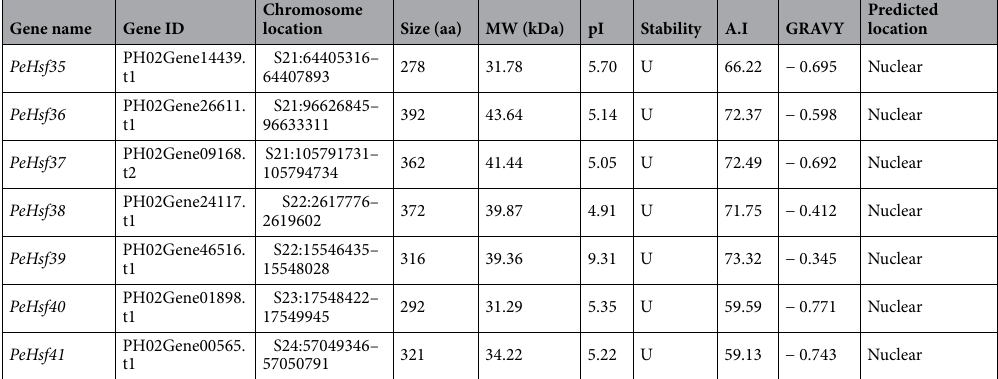
Table 1. Detailed information on 41 PeHsf genes and their encoded proteins. MW molecular weight, pI isoelectric point, A.I. aliphatic index, GRAVY grand average of hydropathicity